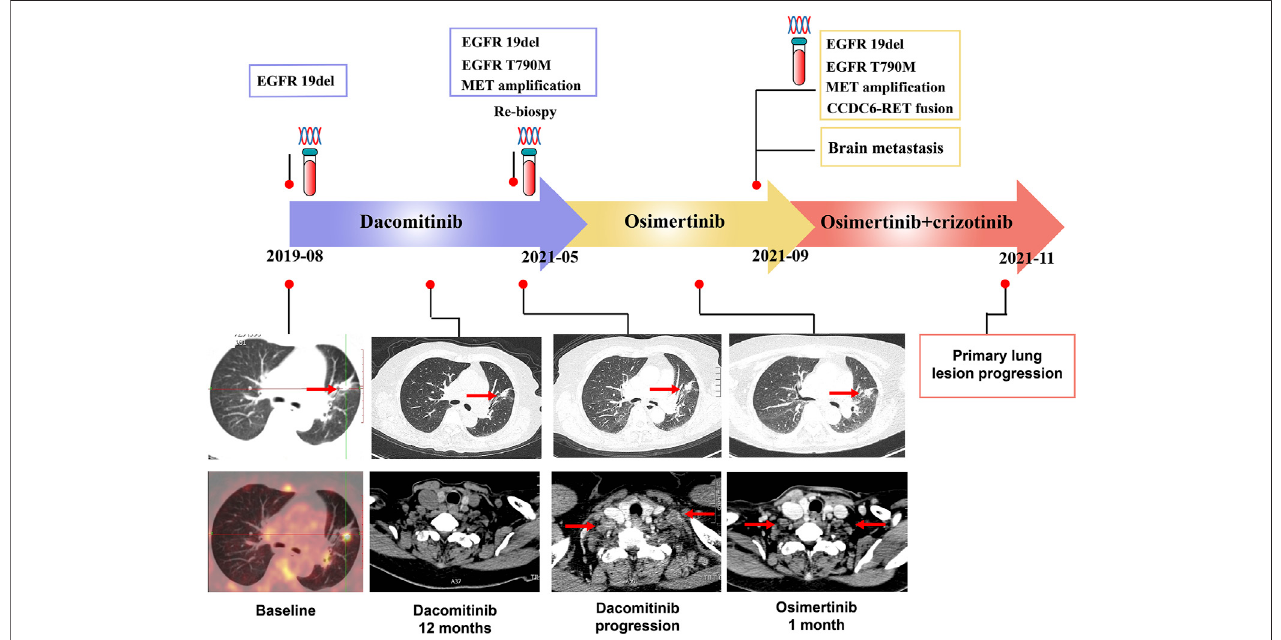
FIGURE2| Timershaft ofgenetestingand treatments measurement,and thecomputed tomographicimages ofprimarylung lesionand lymphnodesmetastases of case 2.